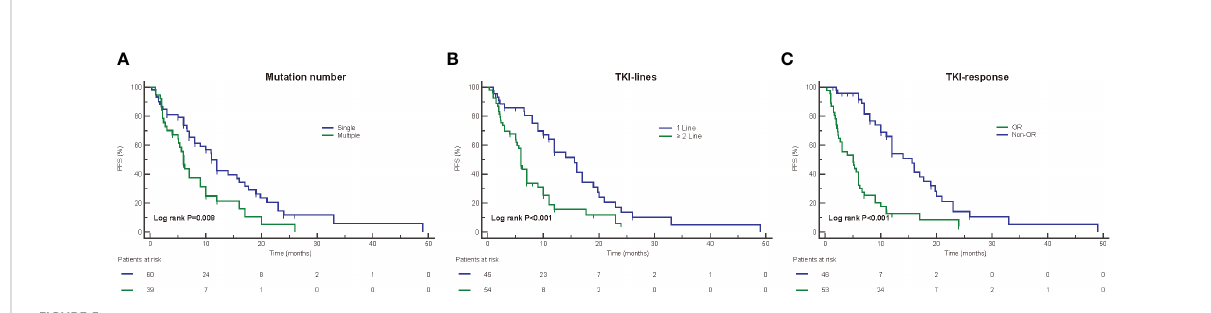
FIGURE 5 Kaplan-Meier curves for progression free survival (PFS) according to mutation numbers (A) , TKI-lines (B) , and TKI-response (C)